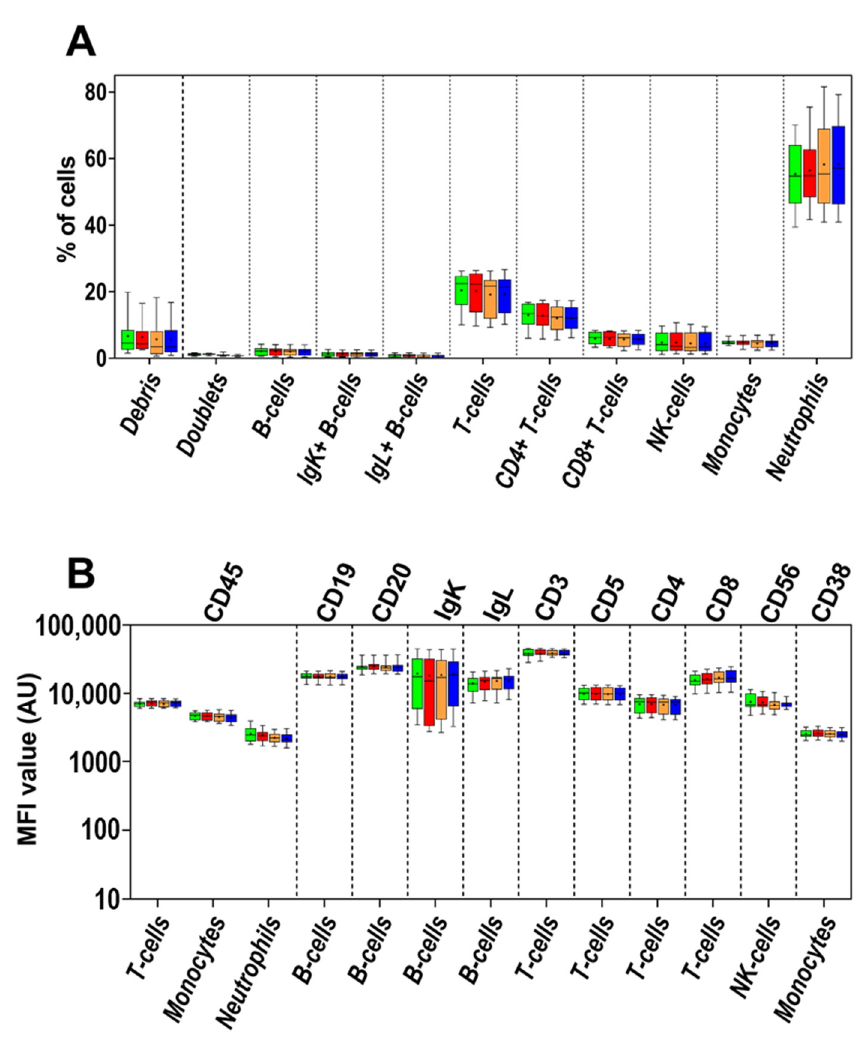
Figure 5. Impact of different pH of the washing buffer on the relative distribution ( A ) and expression levels ( B ) of individual LST markers as assessed on different cell populations in normal PB samples ( n = 20). The plots represent percentages and MFI levels at different pH values, averaged for both BSA concentrations; red boxes—pH = 7.2; green boxes—pH = 7.4; orange boxes—pH = 7.6; dark blue boxes—pH = 7.8. The median and mean MFI values are indicated inside the boxes with a line and “+” sign, respectively. The boxes spread between first and third quartile of the obtained MFI values and whiskers span between minimal and maximal values. Asterisks indicate significant differences between particular time points ( p <